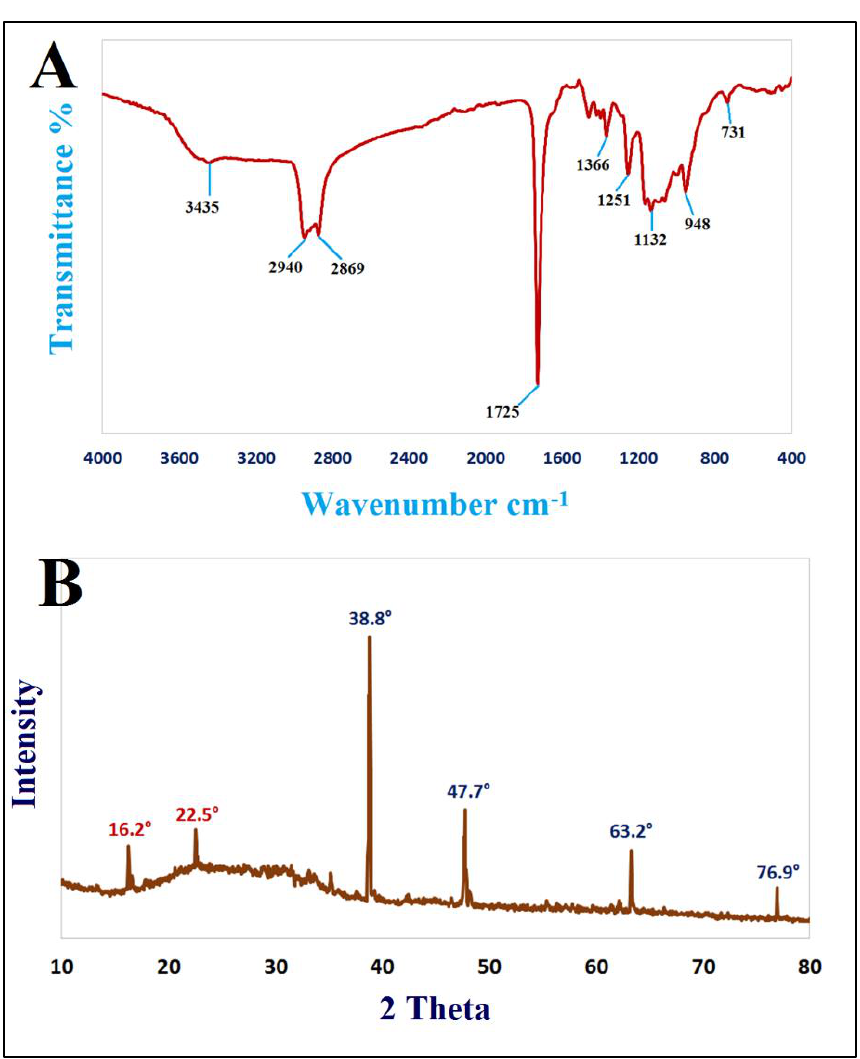
Figure 1. FTIR spectrum ( A ) and XRD pattern ( B ) of Chi/Ag NPs.